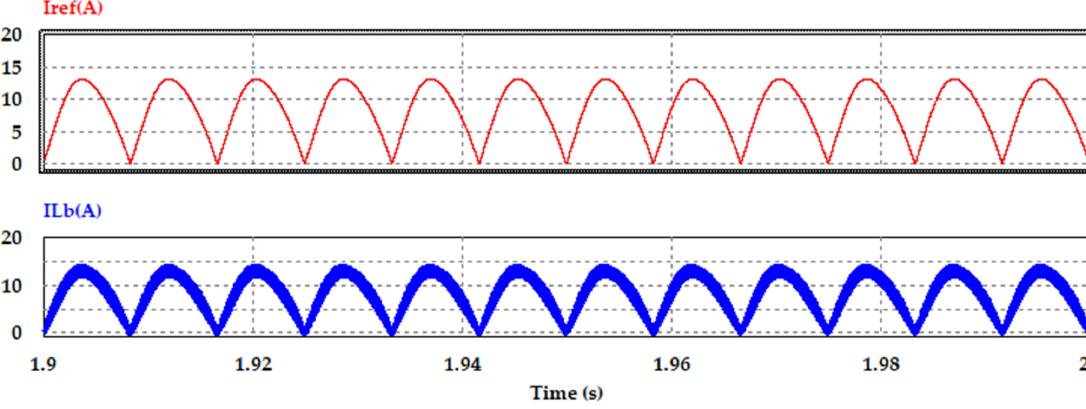
Figure 16. Inductor current and reference current for the conventional CCM PFC at full load condition.